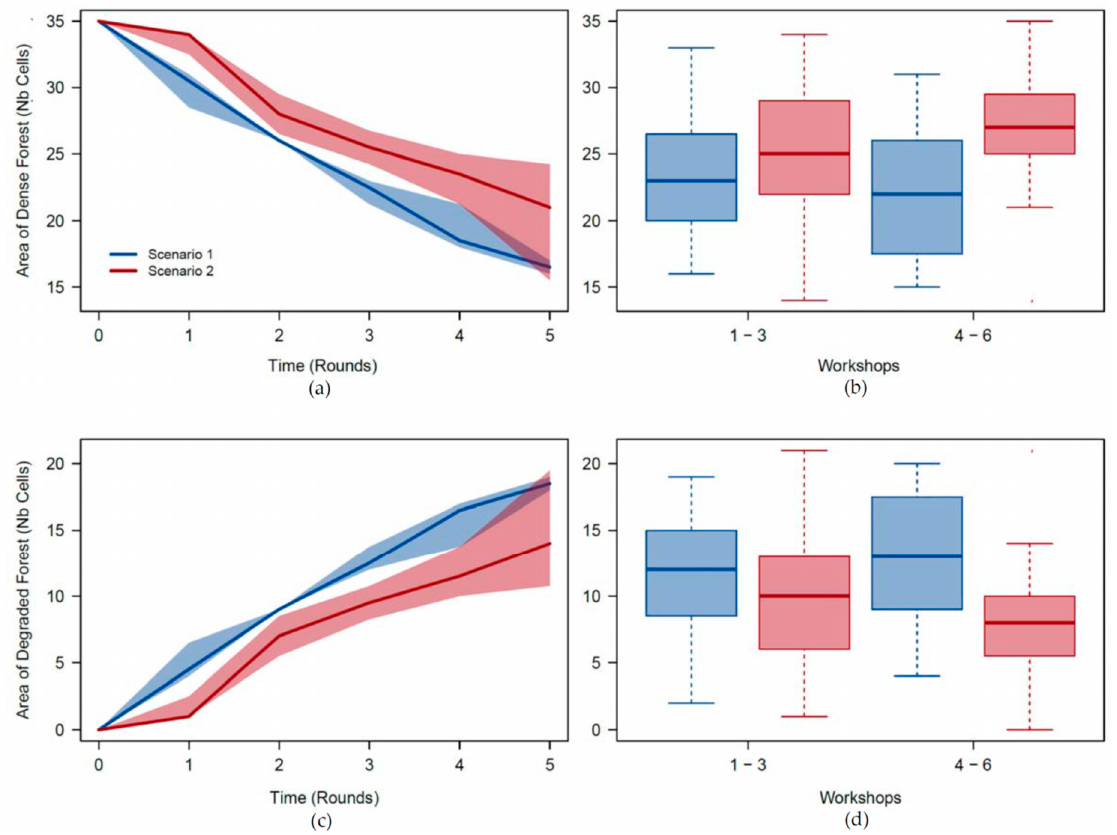
Figure 5. Deforestation and degradation happening in the gamescape. Scenario comparison for the number of plots with dense forest ( a ) and the area of degraded forest ( c ); interactive effects between scenario and workshop for dense forest (boxplots, ( b )) and for degraded forest ( d ).